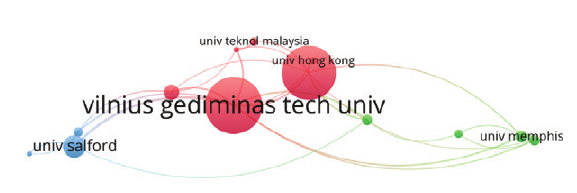
Figure 7. Or ganization citation network of the